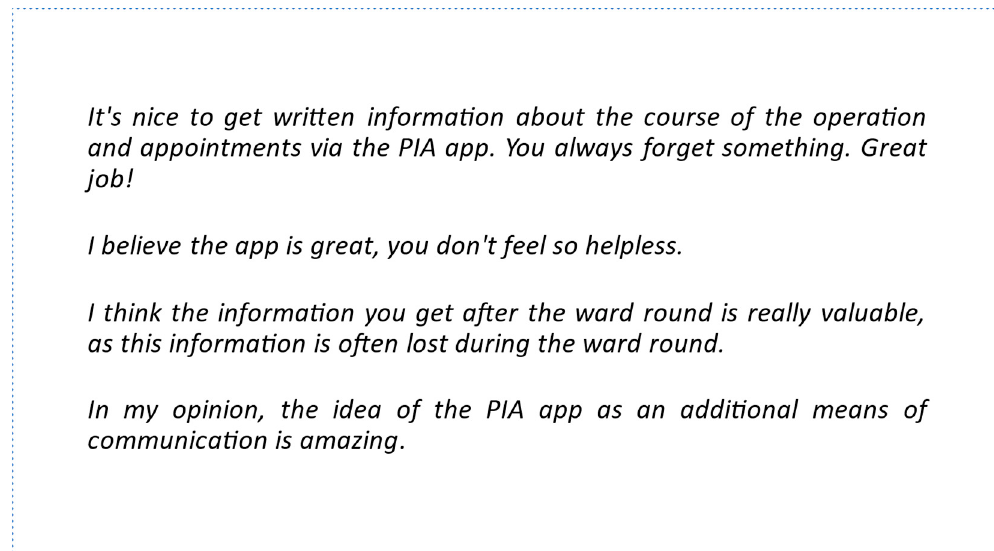
Figure 4. Individual patient feedback on the PIA